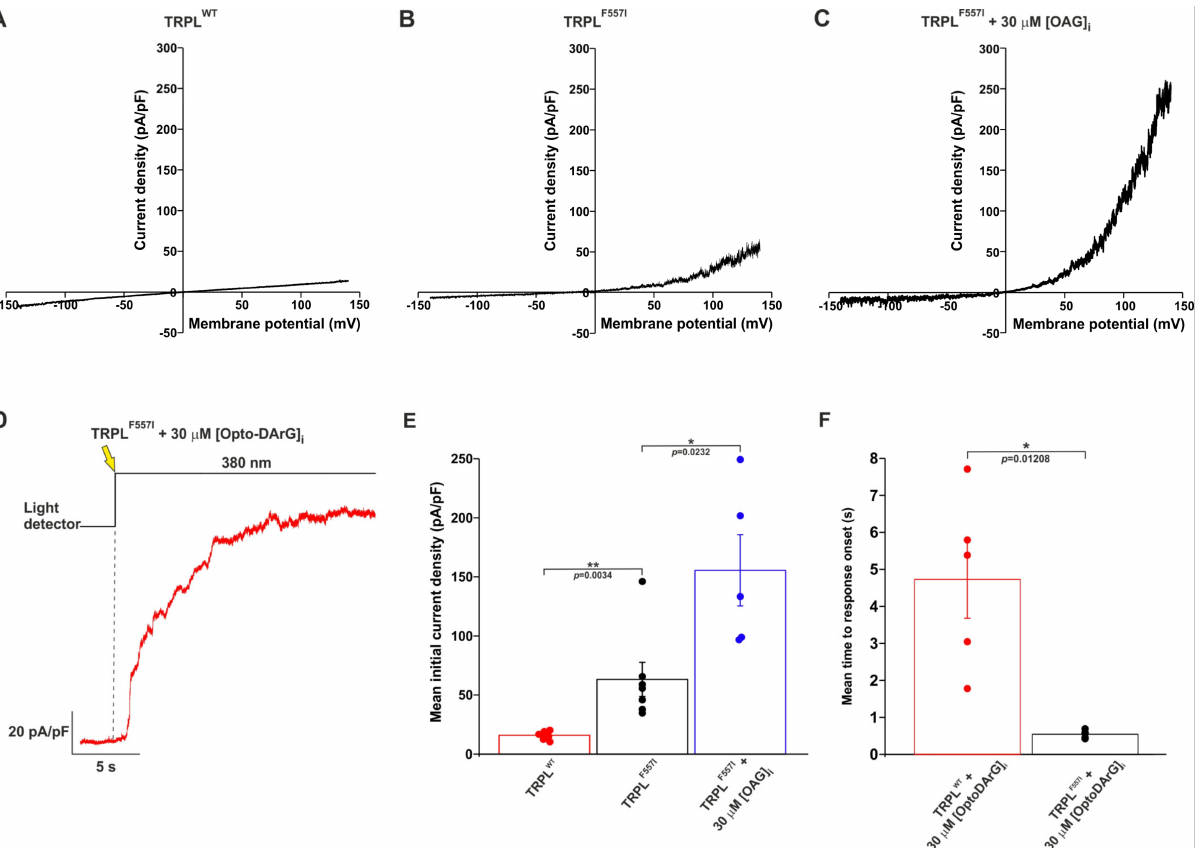
Figure 4. Intracellular OAG enhanced and accelerated the initial basal current of the constitutively active TRPL F557I mutant channel. ( A ) A representative control i-V curve of the initial current